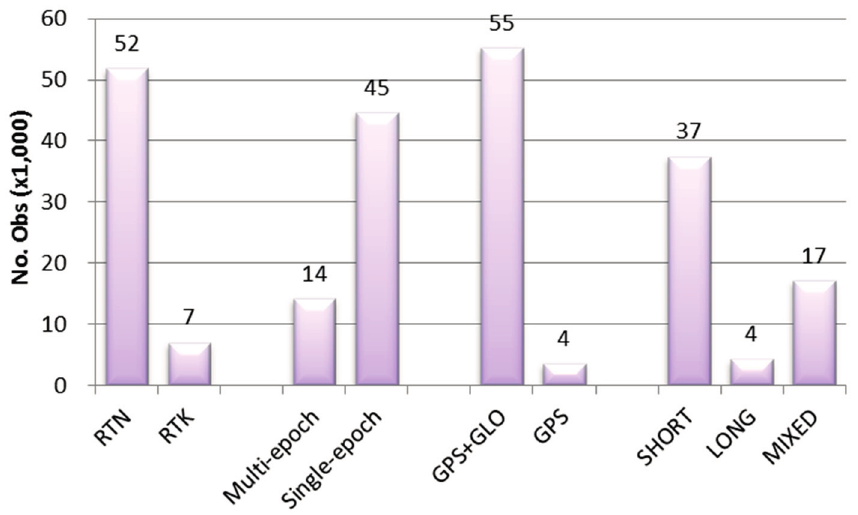
Figure 3. Number of observations by RT types (Phases 1 and 2). SHORT/LONG/MIXED refer to baseline